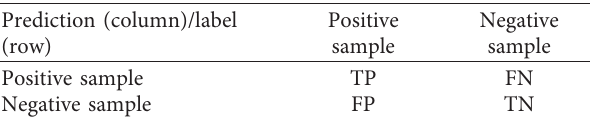
Table 5: Confusion matrix